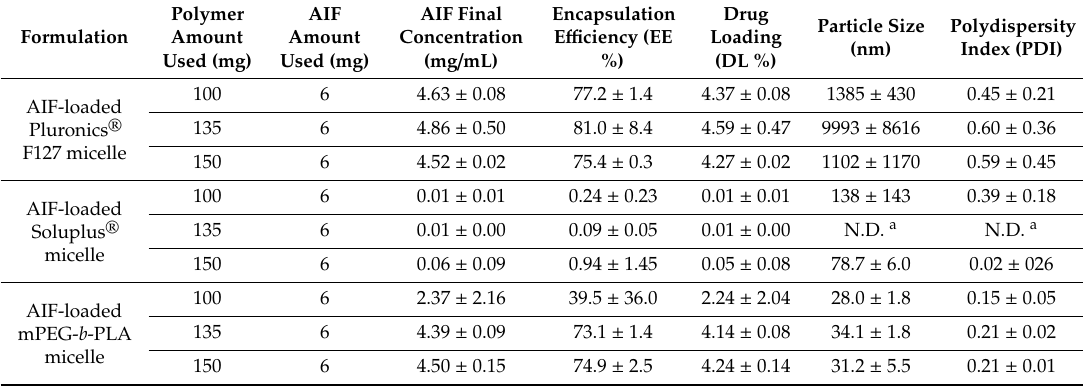
Table 2. Characteristics of alpinumisoflavone (AIF)-loaded micelles ( n = 3, mean ± standard deviation [SD]).